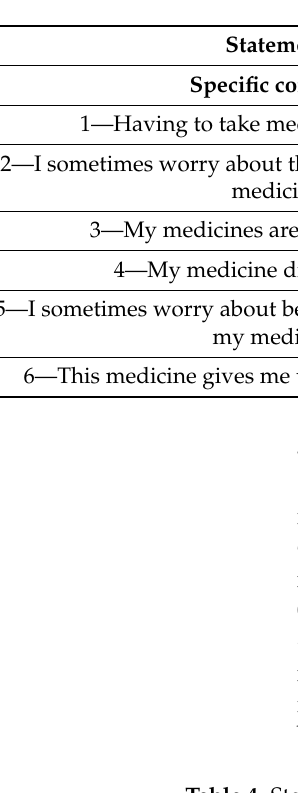
Table 4. Stepwise binary logistical regression of the variables associated with